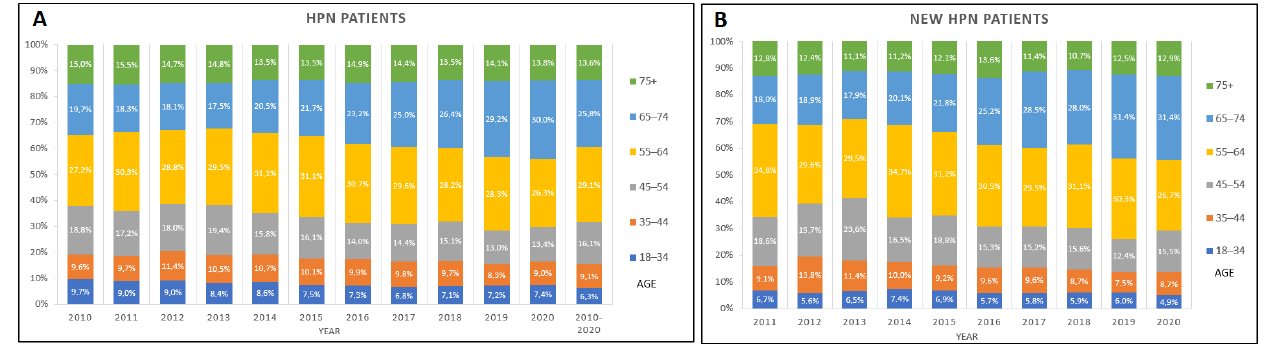
Figure 2. Age distribution. ( A ) — HPN patients, ( B ) — new qualifications.